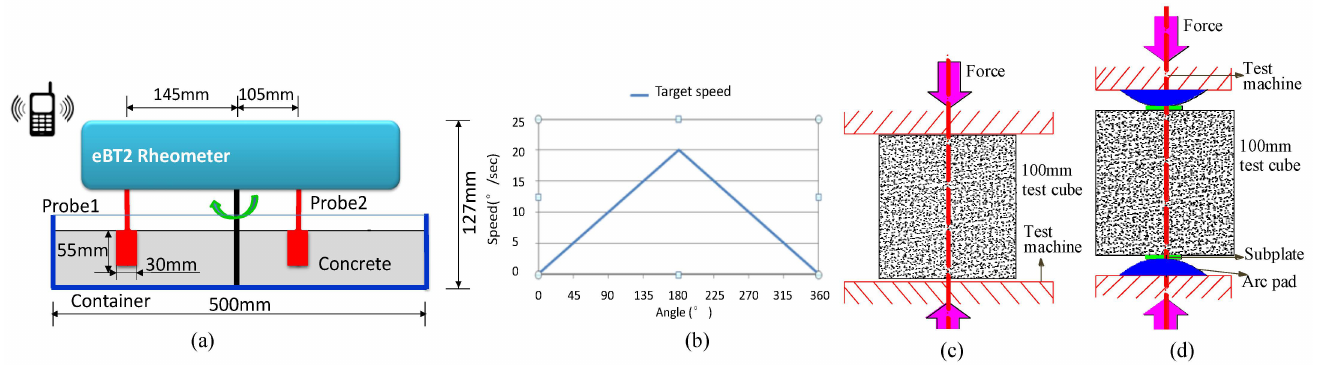
Figure 1. Schematic diagram of eBT2 rheometer ( a ), rotational speed ( b ), compressive test ( c ) and splitting test ( d